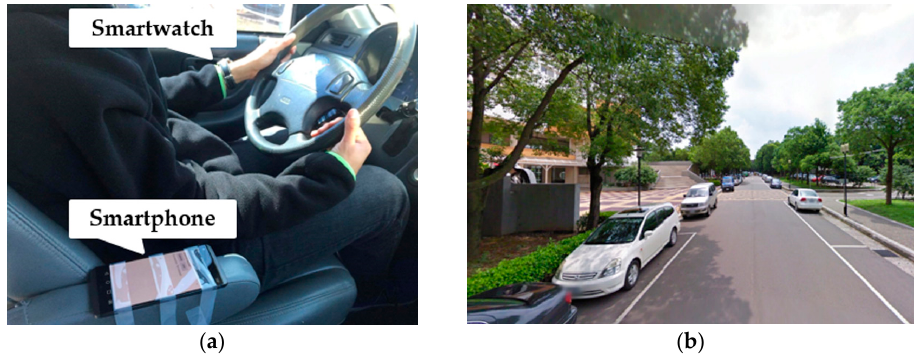
Figure 2. ( a ) Participant in a real vehicle. ( b ) Real-traffic road scene [25].